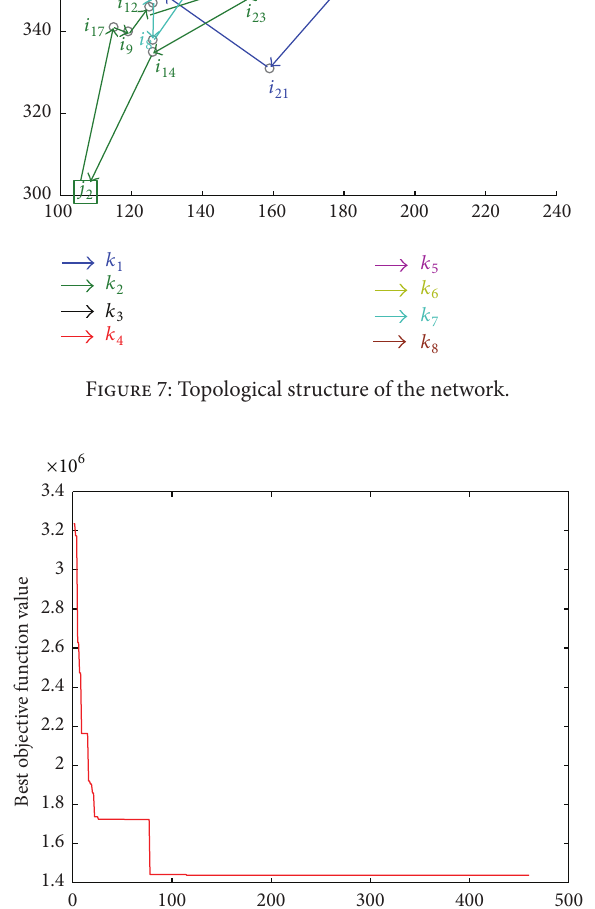
Figure 10: The fluctuation curve of optimal objective function value by